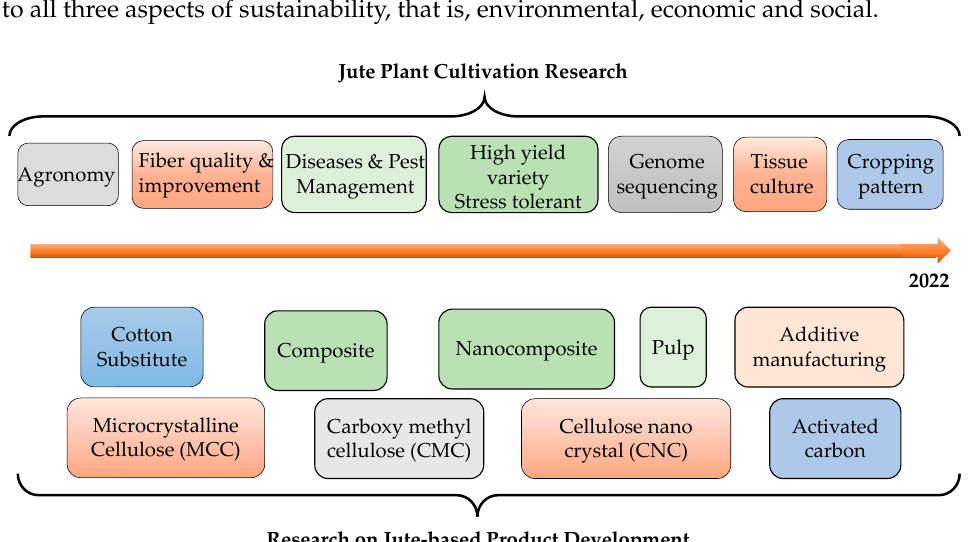
Figure 1. Trend of research on jute plant and fiber.